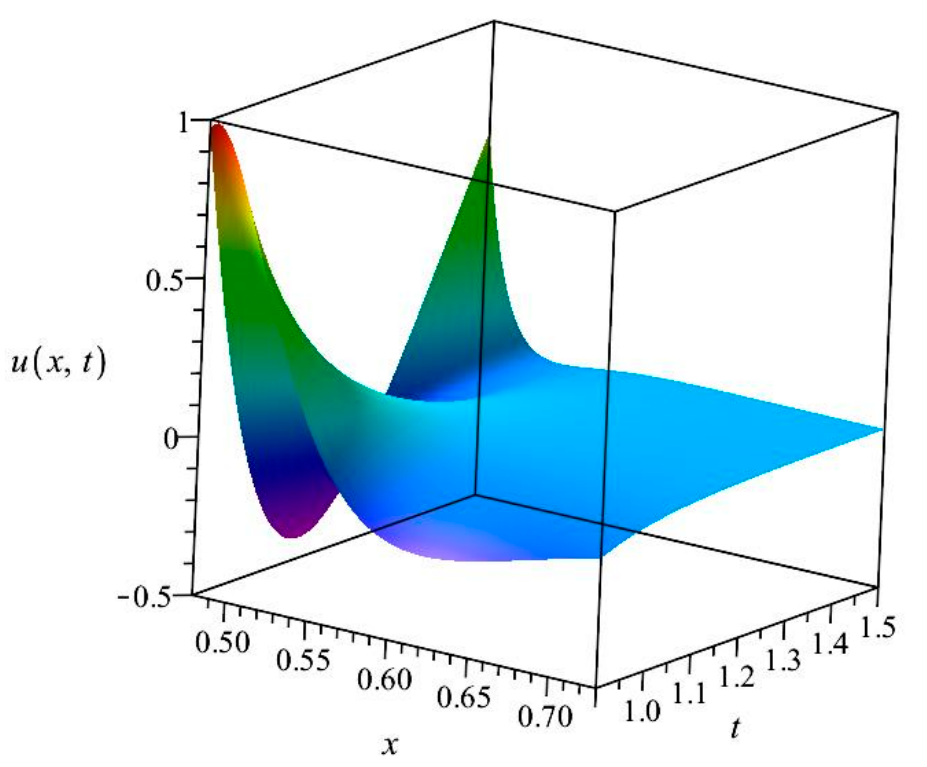
Figure 3. The solution u ( x , t ) of Equation (2) with the shape function Equation (4) for D = 1, m = 7.2, α = 11.4, c 1 = 0, c 2 = 0.0042, x ∈ [ 0.48, 0.73 ] , t ∈ [ 0.9, 1.5 ]